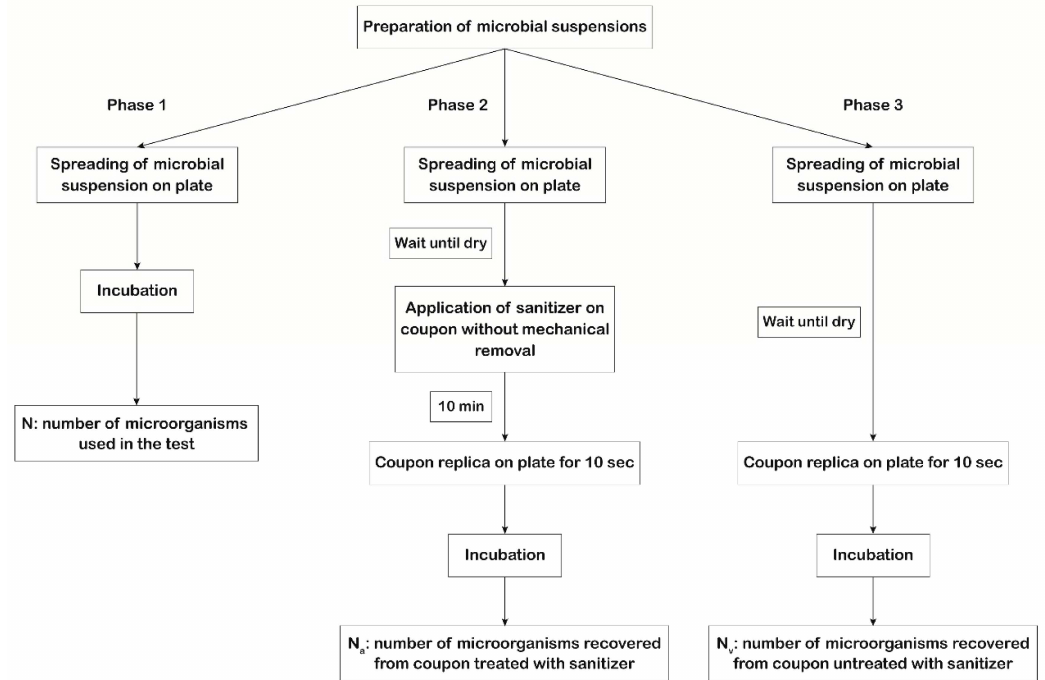
Figure 1. Scheme of the experimental plan used to evaluate disinfectants’ efficacy. In phase 1, 100 µ L of each microbial suspension was plated in triplicate, and for each microorganism, the titer of the mother suspension was determined (N). In phase 2, 100 µ L of each microbial suspension was applied, in triplicate, on the coupon surface with a spreader. After drying, the disinfectant was applied without mechanical removal (worst case scenario). After 10 min of action, sampling of the coupon surface was performed by direct replication on plates to determine the number of vital microorganisms that survived the action of the disinfectant (N a ). In phase 3, 100 µ L of each microbial suspension was applied, in triplicate, on the coupon surface with a spreader. After drying, sampling of the coupon surface was performed by direct replication on plates to determine the number of vital microorganisms dispensed on the coupon surface (N v